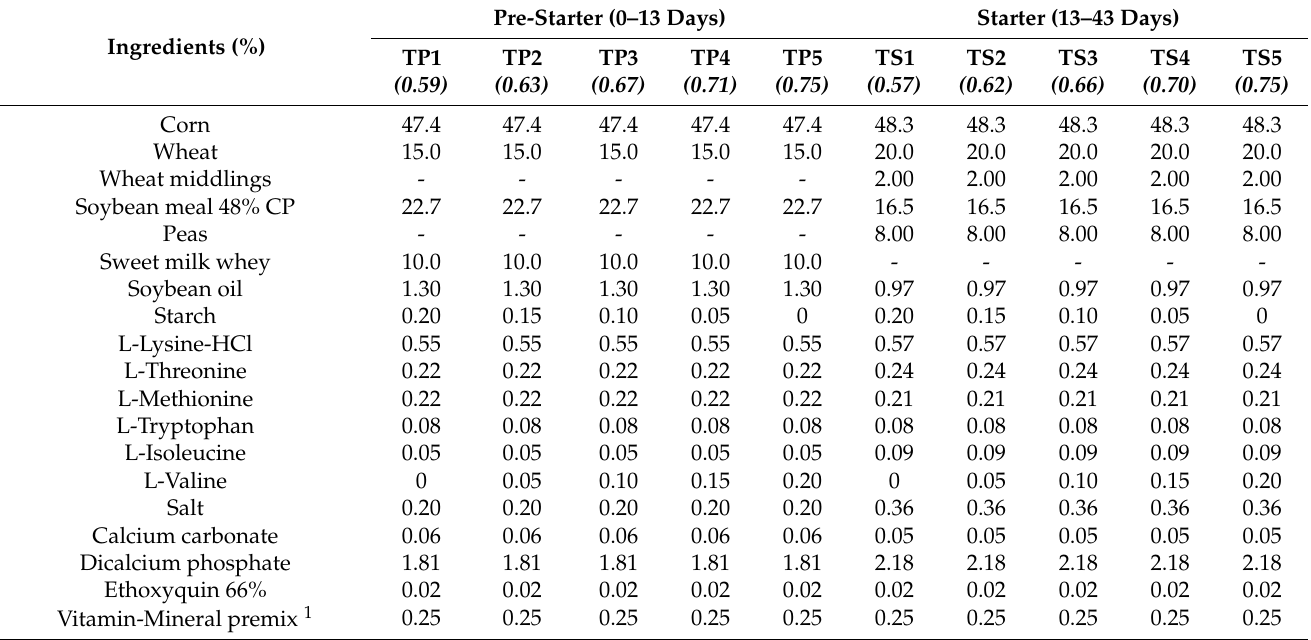
Table 1. Feed ingredients in the treatment (T)